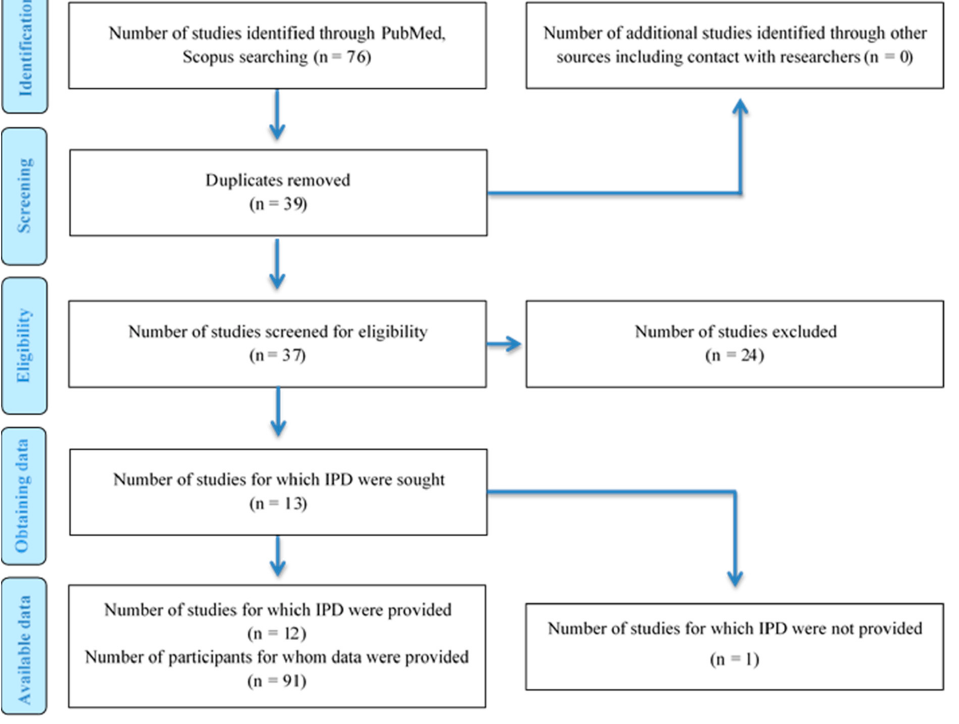
Figure 1. Prisma flowchart. IPD: Individual Patient Data.